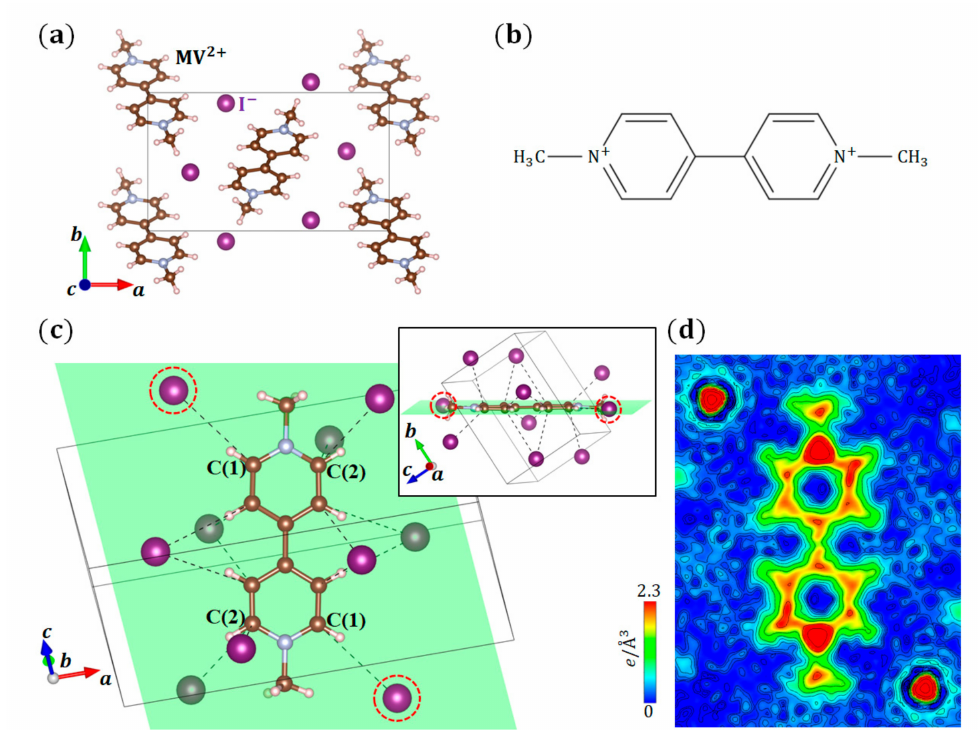
Figure 5. ( a ) Crystal structure of (MV)I 2 ; ( b ) Molecular structure of MV 2 + ; ( c ) Relationship between a − MV 2 + molecule and surrounding I ions. There is an inversion center at the central C–C bond in the MV 2 + molecule. The least square (LS) plane, on which the central six C atoms are located, is shown in − green. The I ions surrounded by the red dotted circles exist near the green plane. ( d ) VED distribution of the MV 2 + molecule. This density plane corresponds to the green plane in ( c ). The orientations of the MV 2 + molecules are the same between ( c , d ).